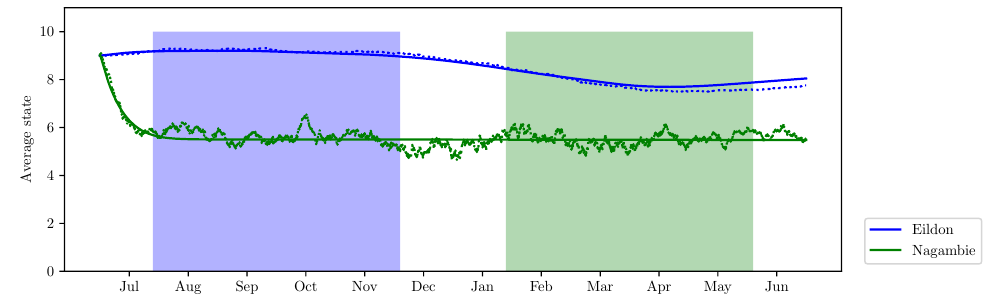
Figure 7. Average levels of Lakes Eildon and Nagambie for program